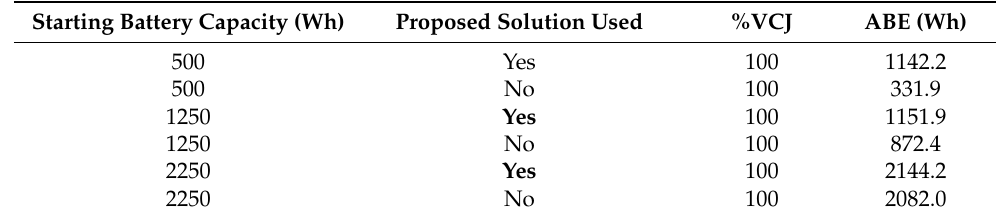
Figure 6. The achieved travel time under varying starting battery capacities and CS stop durations: the case of the grid road network. Table 4. Our detour computation scheme vs. the SUMO baseline routing algorithm: the case of the grid road